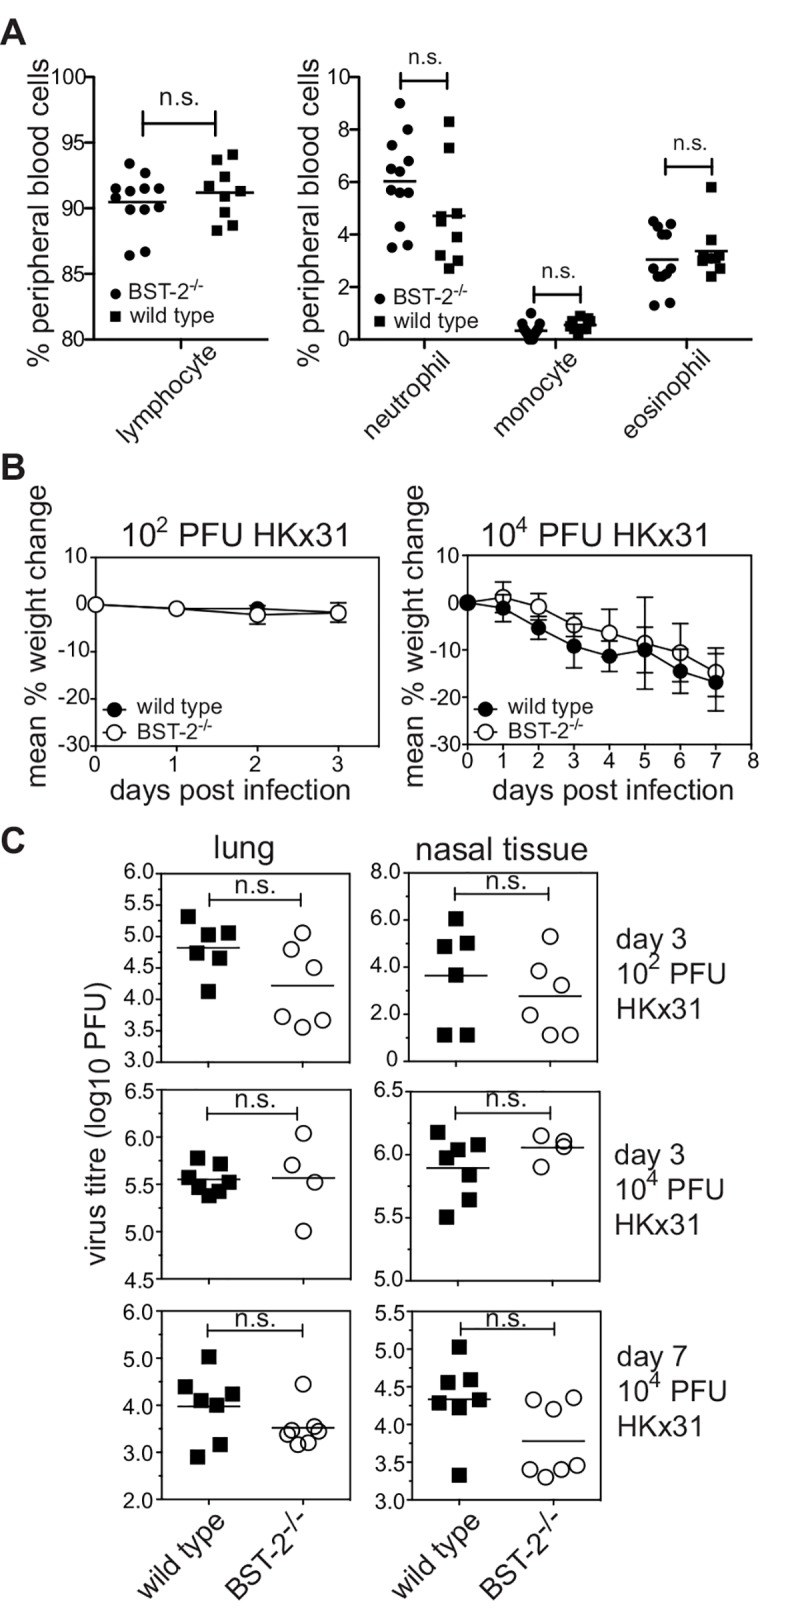
Lack of BST-2 does not alter the susceptibility of mice to IAV infection or the ability of IAV to replicate in the airways.(A) Peripheral blood from wild type and BST-2-/- mice was screened by the Advia2120 automated hematology analyzer. Each symbol represents an individual mouse and the bar indicates the mean. n.s. = no significant difference, p = > 0.05, two way ANOVA followed by Bonferroni analysis. (B) Wild type and BST-2-/- mice were infected with either 102 PFU or 104 PFU of HKx31 via the intranasal route. Mice were weighed daily and the results expressed as the mean percentage weight change per group (± 1 SEM) relative to original body weight. (C) Virus titres were determined in clarified homogenates prepared from lungs and nasal tissues using a standard plaque assay on MDCK cells. Symbols show titres from individual animals and horizontal bars represent the mean virus titre. n.s. = no significant difference, p = > 0.05, Student’s t-test; two-tailed.